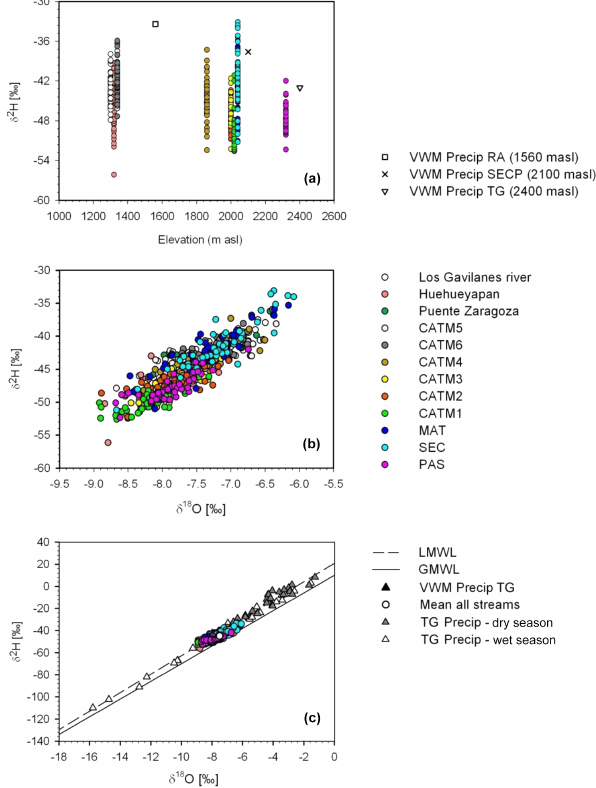
Figure 2. (a) Relationship between δ 2 H signatures of stream base flow and elevation of the catchment outlets (i.e., the sampling loca- tions), and volume-weighted means (VWMs) of the deuterium com- position of rainfall at the three elevations within the Los Gavilanes river catchment; (b) δ 18 O versus δ 2 H signatures of baseflow from the 12 catchments investigated; and (c) isotope ( δ 18 O versus δ 2 H) signatures of rainfall and stream baseflow. The local meteoric water line (LMWL; dashed line) is based on the 2008–2010 precipitation at TG, and reads: δ 2 H = 8.36 · δ 18 O + 20.37; the solid line repre- sents the global meteoric water line (GMWL): δ 2 H = 8 · δ 18 O + 10.